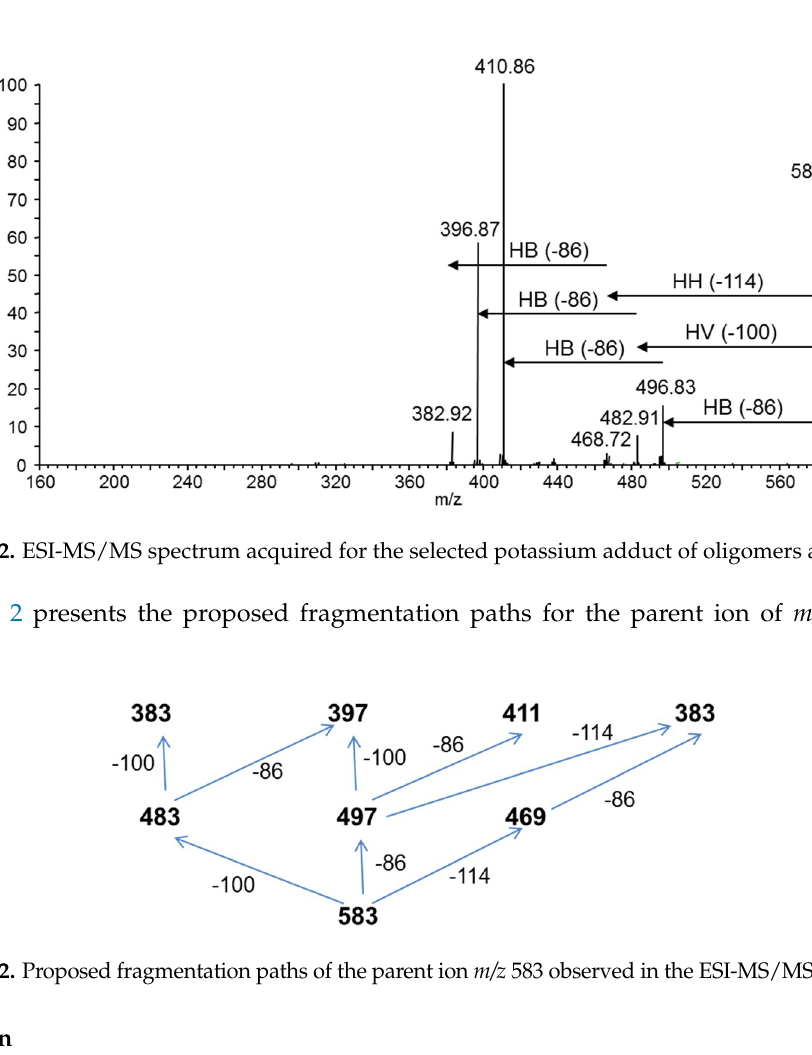
Figure 11. ESI-MS/MS spectrum obtained for the selected potassium adduct ion of the oligomers, [HB 5 HV + K] + , at m/z 569.